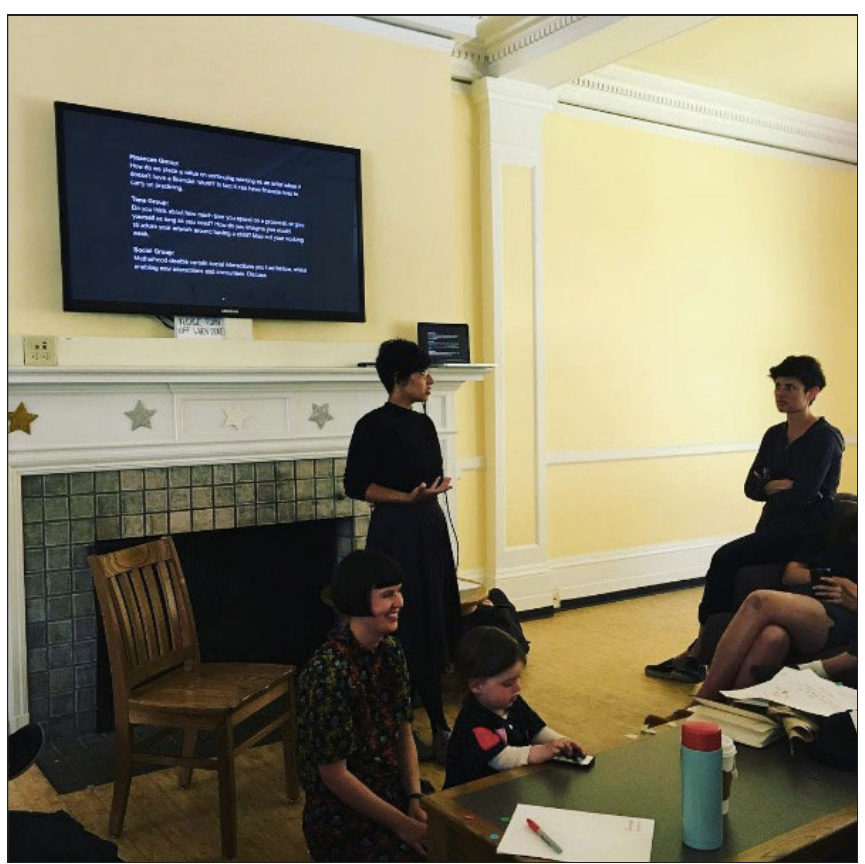
Figure 9: Davina Drummond & Yara El-Sherbini, A Lesson on Motherhood . A lecture on balancing motherhood and art at Portland State University, British Council Fel- lowship,